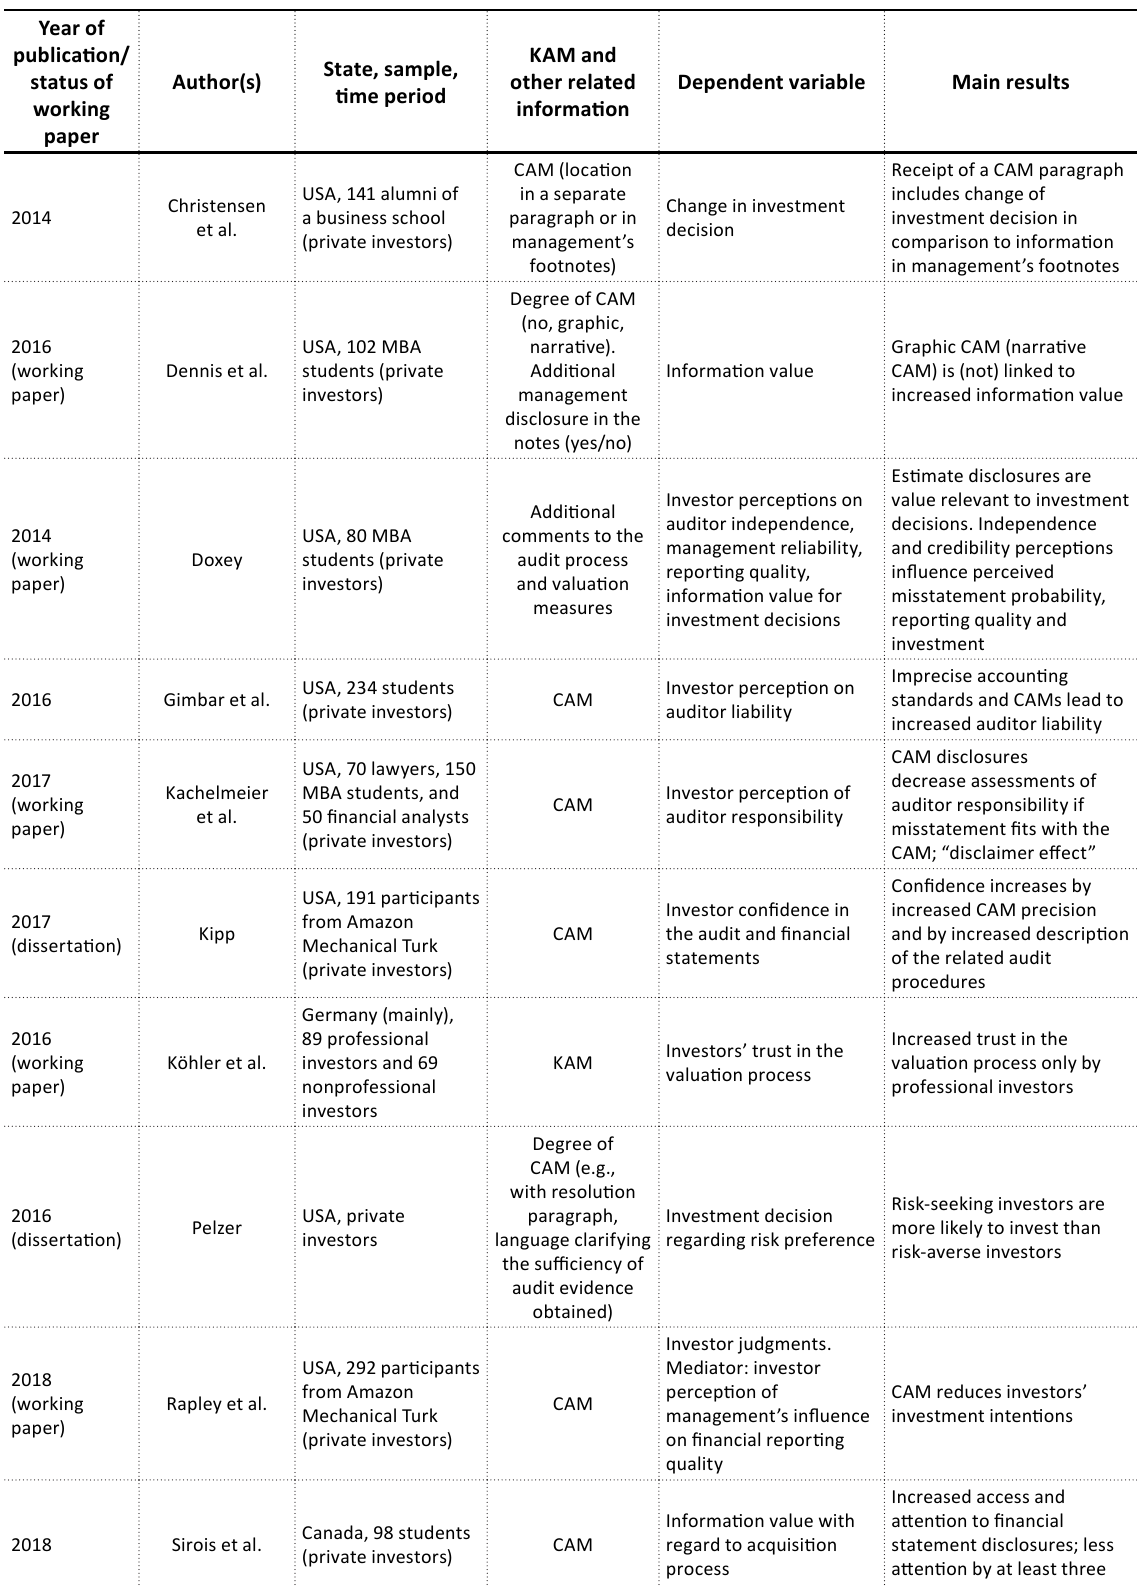
Table 3 (cont.). Overview of empirical research regarding the impact of KAM and other related information on